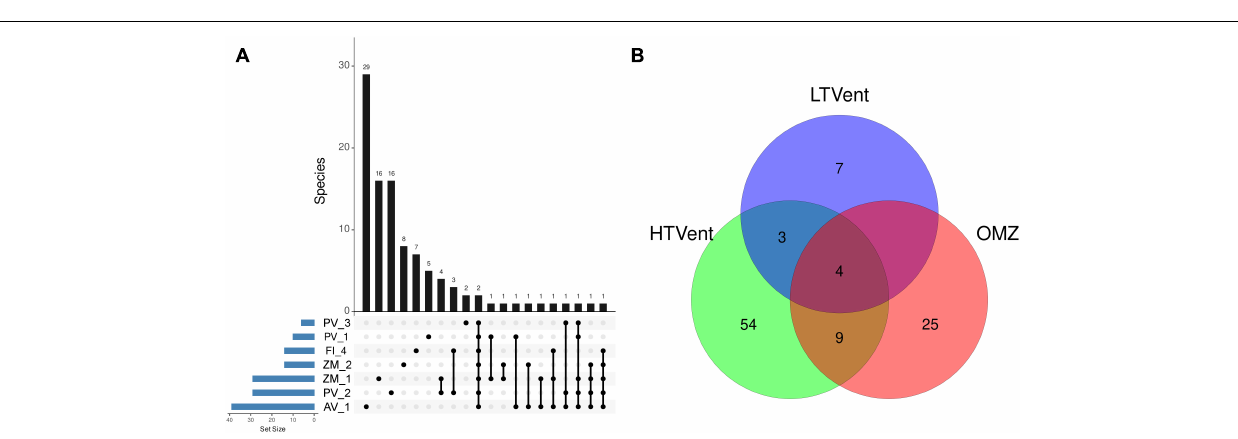
FIGURE 9 | Upset plot indicating overlapping and unique fungal AVSs across the seven sampling sites stacked in the x -axis (A) , where the set size represents the overall number of species for each sample; and Venn diagram (B) showing the total number of shared and uniquely retrieved fungal AVSs in deep-sea low-temperature hydrothermal vents, high-temperature hydrothermal vents, and an oxygen minimum zone. HTVent, high-temperature vents; LTVent, low-temperature vent; OMZ, oxygen minimum